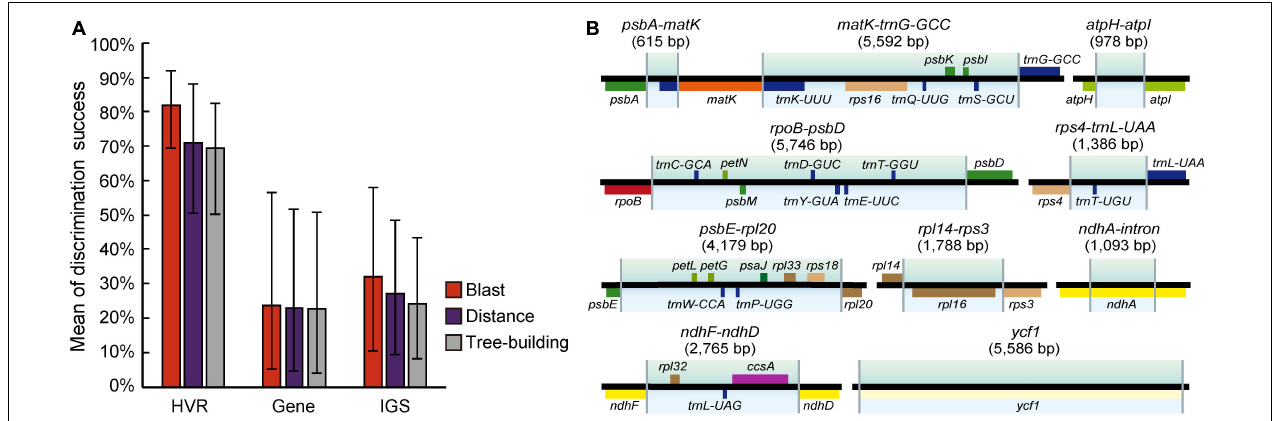
FIGURE 6 | Average discriminatory power with error bars donated standard deviation (SD) of HVRs, genes, and IGSs based on three methods (A) and the aligned length of HVRs and genes/IGSs involved in them (B) . The size of these regions is highlighted with the gradient colors. Genes above the line are transcribed clockwise, and genes shown over the line are counterclockwise. Rectangles in assorted colors represent the corresponding gene function. More details about these functions are shown in Supplementary Figure 2 and Supplementary Table 4